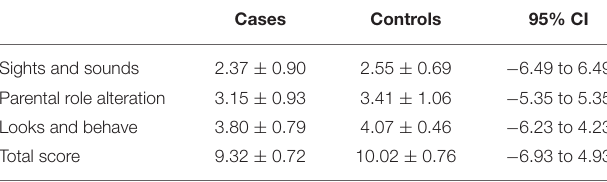
TABLE 2 | Stress levels of parents of an ELGAN assessed with the PSS: NICU questionnaire at the age of 5–7 months: comparison of cases having received standardized information on ECI at the age of about 4 weeks with controls without information. Cases